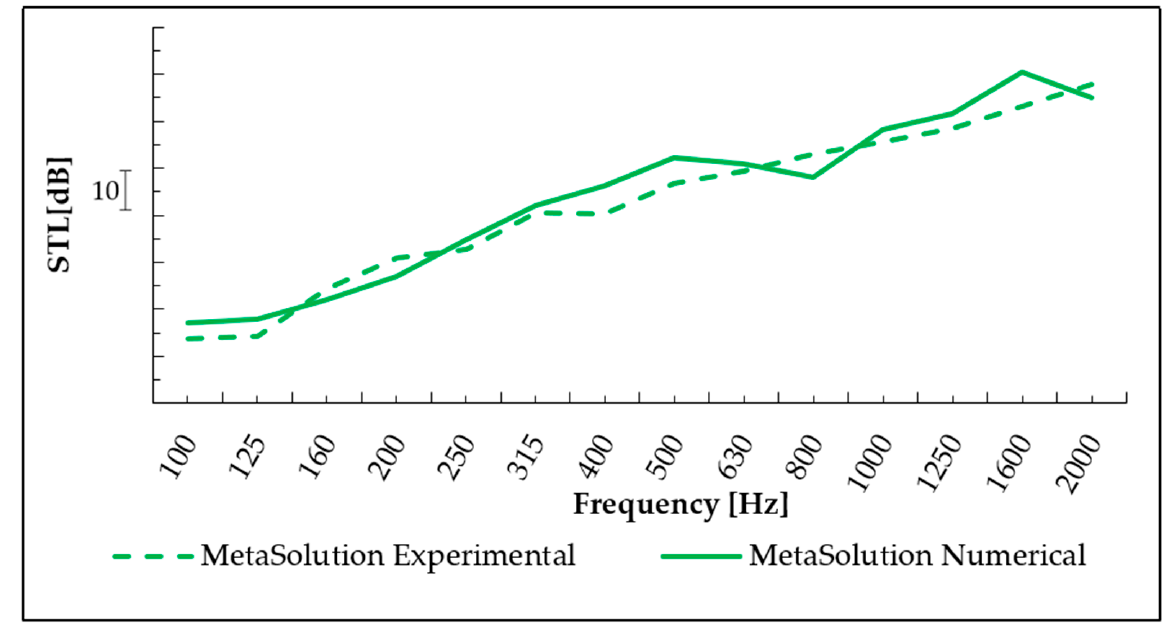
Figure 9. Numerical vs. experimental STL for Metasolution.